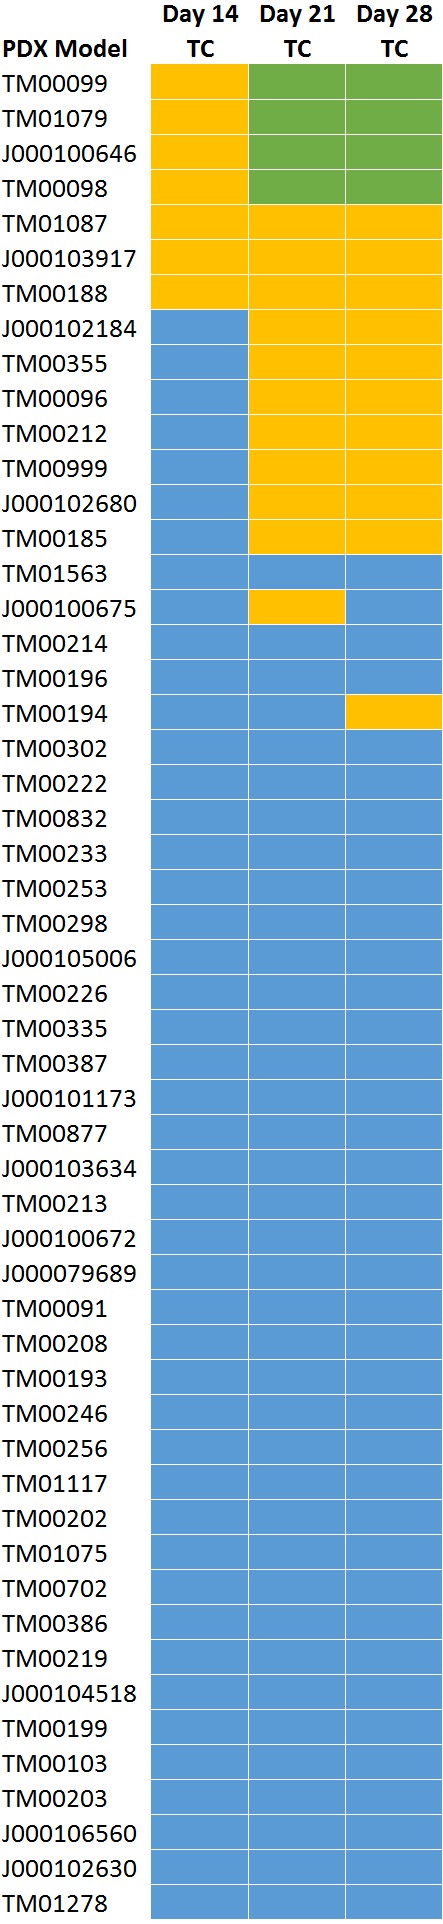
TC Response classification at study day 14, 21, and 28.All models classified as highly responsive or responsive on day 21 were consistent with those classified on day 28 with the exception of one model (TM00194).